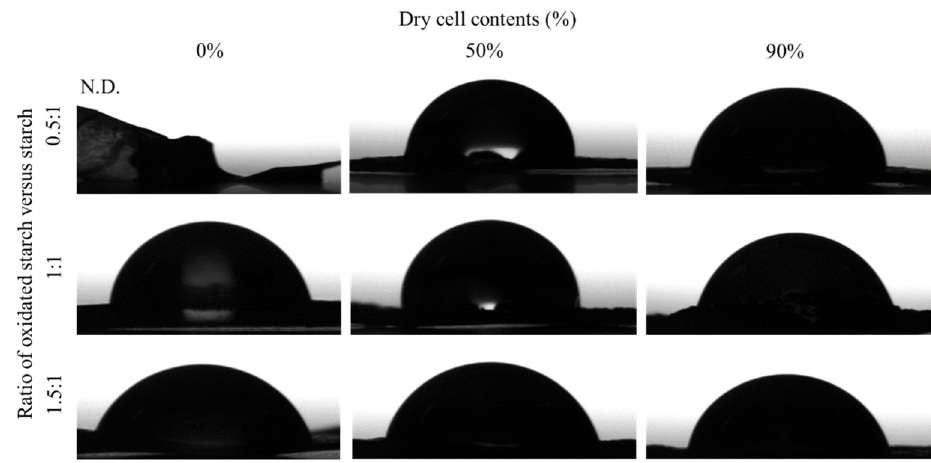
Figure 5. Evaluation of water repellency of each starch cell-plastic.